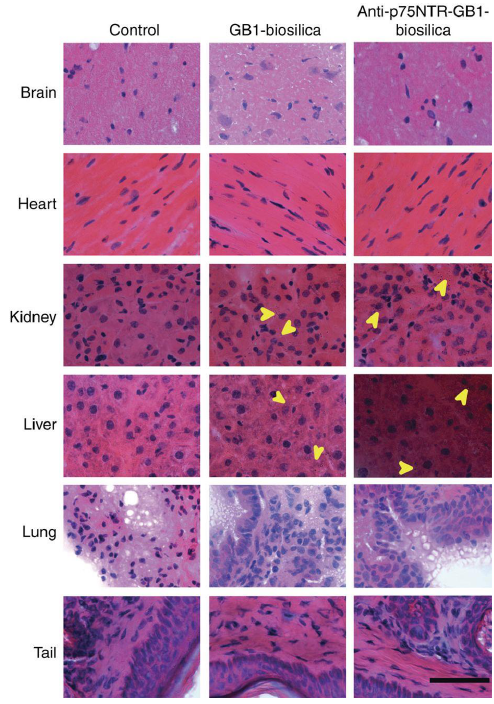
Figure 2. In vivo nude mice biodistribution and tissue damage studies of diatom biosilica structures after eight days of treatment. The tissues appear normal; some biosilica fragments are evident in the kidney and liver samples of mice. Yellow arrows point to biosilica in tissue sections. Scale bar, 50 μm. Reproduced with permission from [43], Nature,